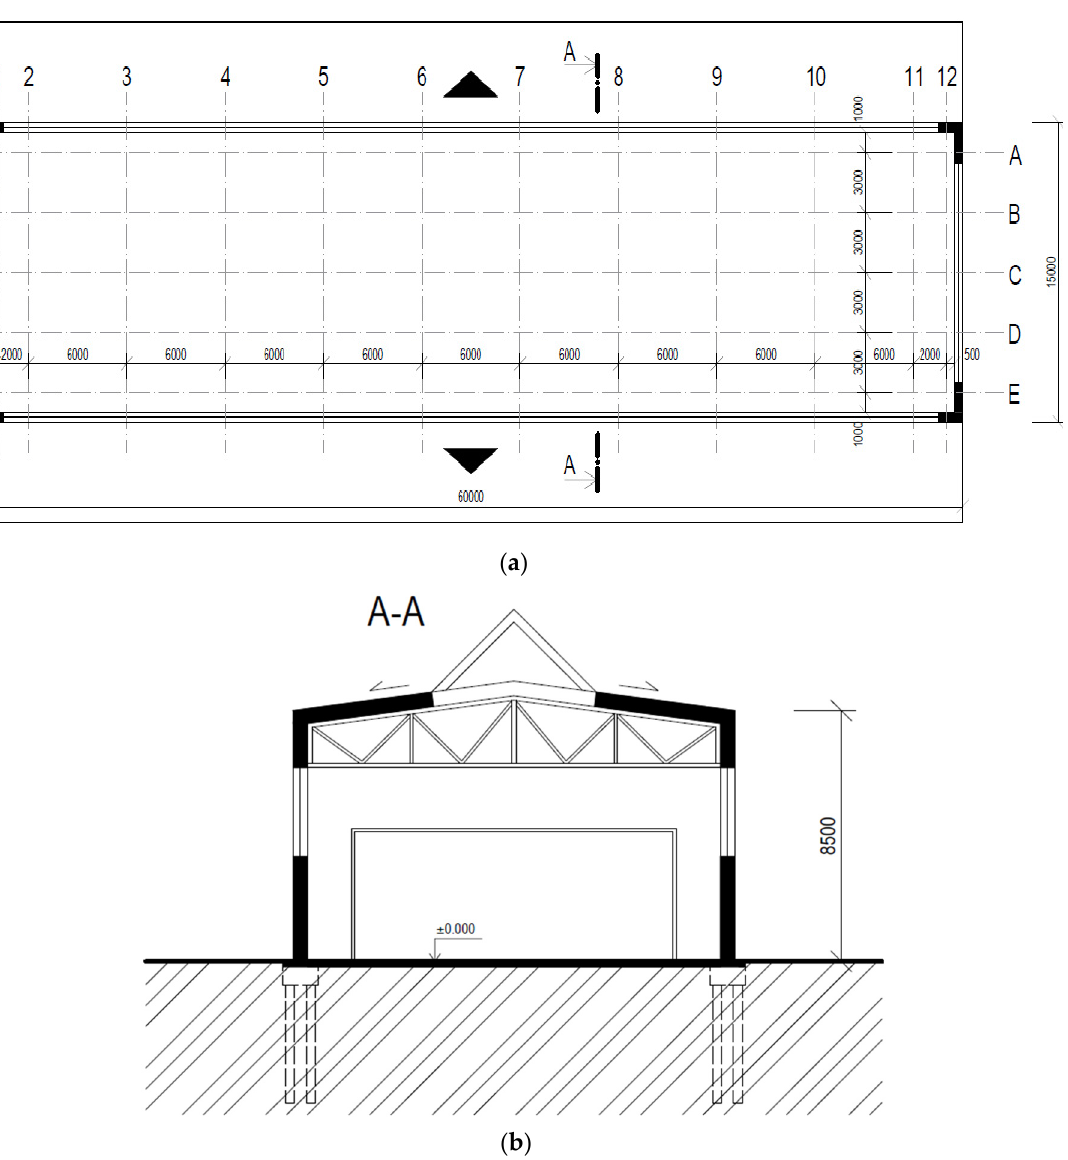
Figure 5. ( a ) ground floor—measured control points. ( b ) cross-section of selected hall building.